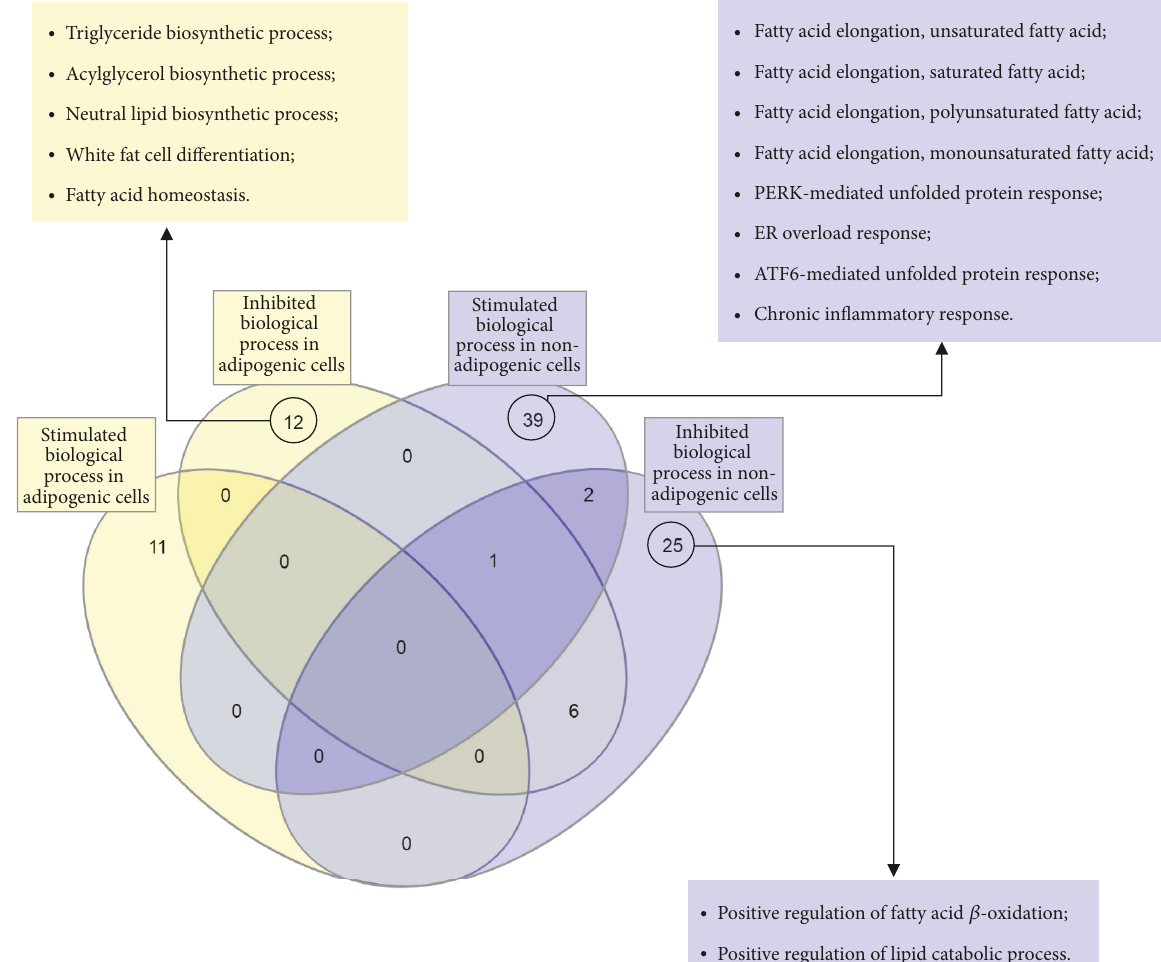
Figure 10: Gene ontology for seipin loss-of-function . InteractVenn [43] allowed us to see four different clusters formed when seipin loses its function in different cell types. All of the biological processes had a fold enrichment >